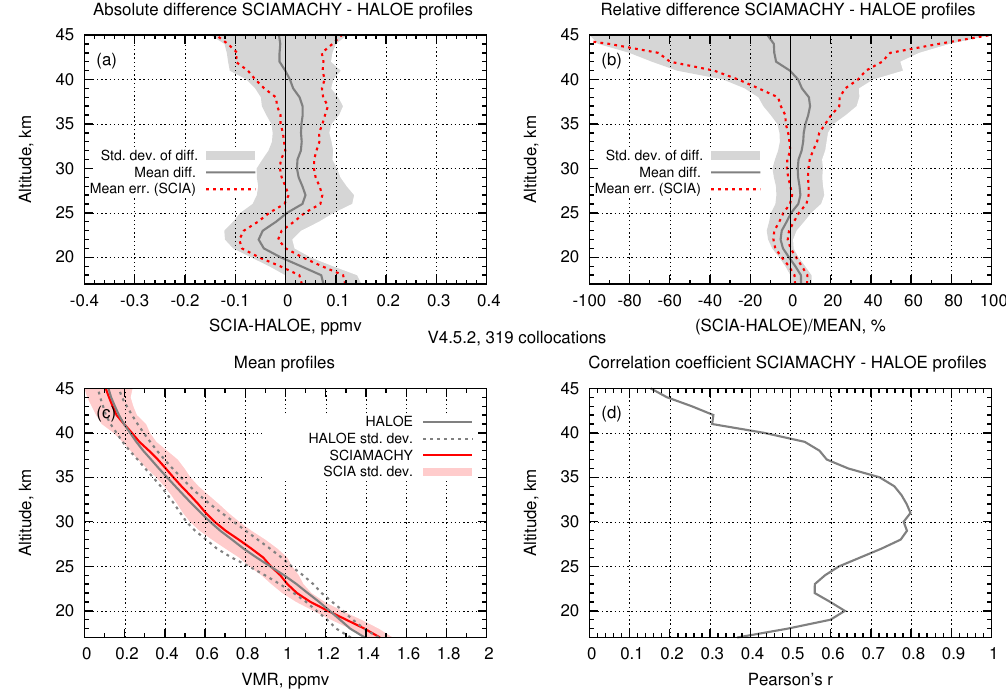
Figure 9. Same as Fig. 8, but for comparison of retrieved SCIAMACHY CH 4 profiles (ONPD V4.5.2, red) with HALOE v19 sunset data